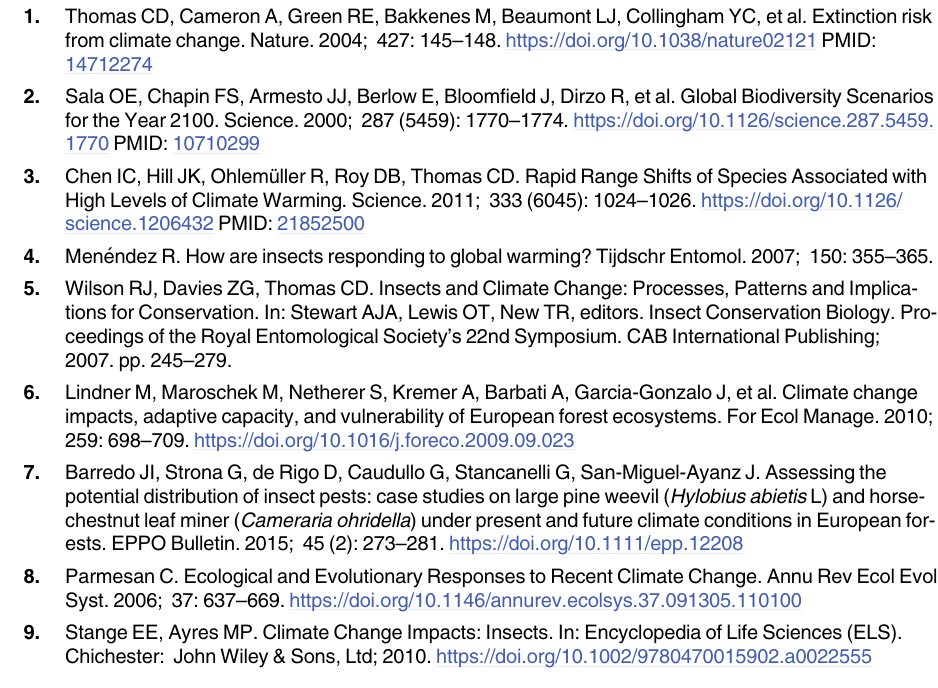
S3 Table. Percentages of range reduction/expansion relative to current distributions for species of the genus Pipiza in Europe based on the BCC_CSM1.1, CCSM4 and Had- GEM2-ES climate model predictions and for different climate change